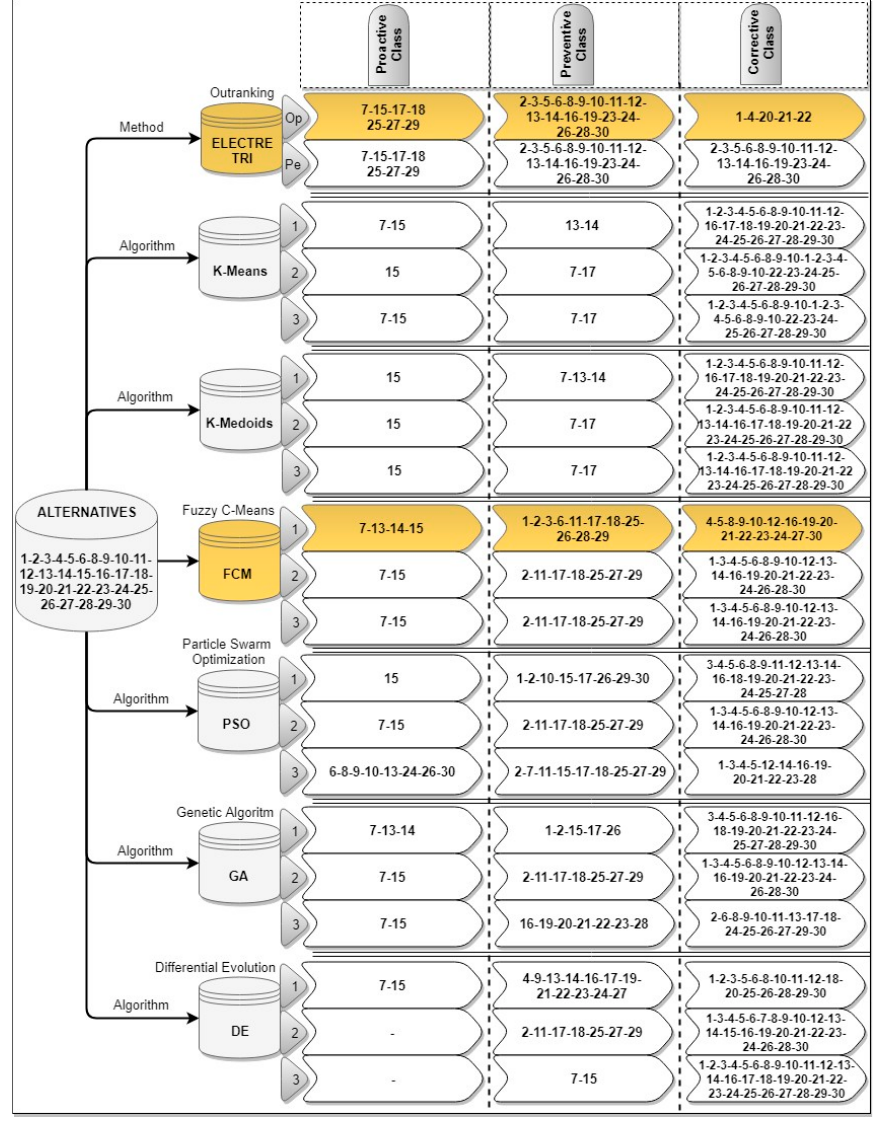
Figure 4. First Results and comparisons. Energies 2023 , 16 , x FOR PEER REVIEW 20 of 25